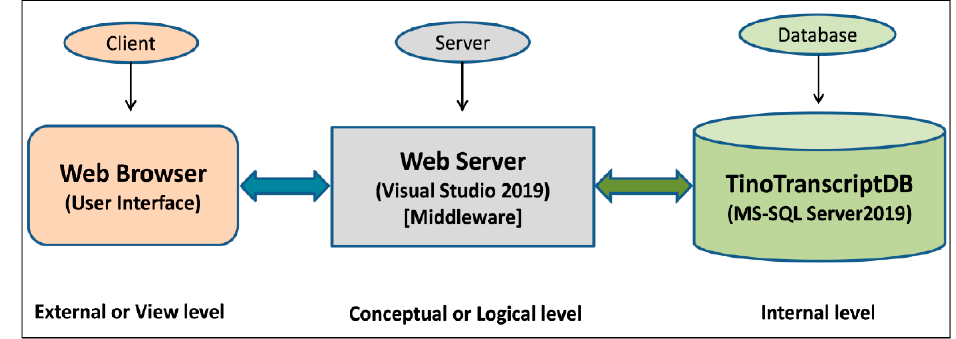
Figure 1. Three-level database schema architecture used for the construction of TinoTranscriptDB.